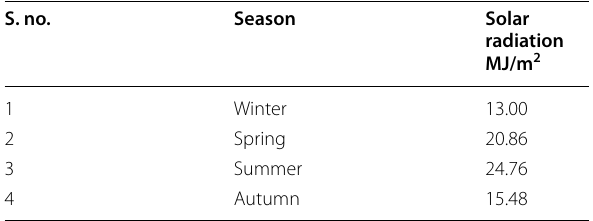
Table 6 Climatic solar radiation in Kathmandu, Nepal (Poudyal et al.,